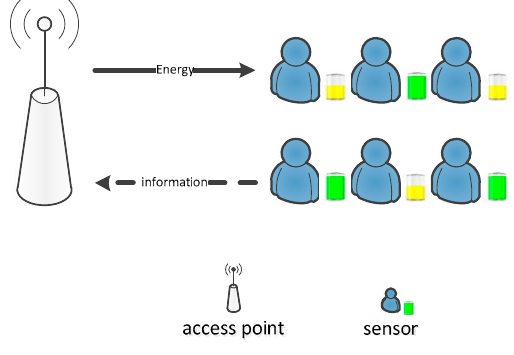
Figure 1. Wireless sensor network powered by RF energy.